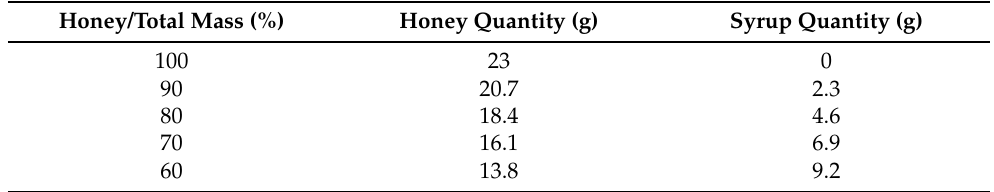
Figure 2. Sample preparation used for the acquisition of the transmission spectrum of honey from Guindo Santo and Quillay mixed with different syrups (Fructose, Glucose, High Maltose). View of the mixing preparation and all samples used. GSG, GSM and GSF are indicated for Guindo Santo honey mixed with Glucose, High Maltose, and Fructose syrups, respectively, and QG, QM, and QF for Quillay honey mixed with the same syrups. The references correspond to two samples of 100% honey for each case (GS-100 1 and GS-100 2 for Guindo Santo and Q-100 1 and Q-100 2 for Quillay) and 100% syrups, one for each case (G-100: 100% Glucose; M-100: 100% High Maltose; F-100: 100% Fructose). Table 1. Values of percentages and masses of the mixtures analyzed correspond to Quillay and Guindo Santo’s honey samples